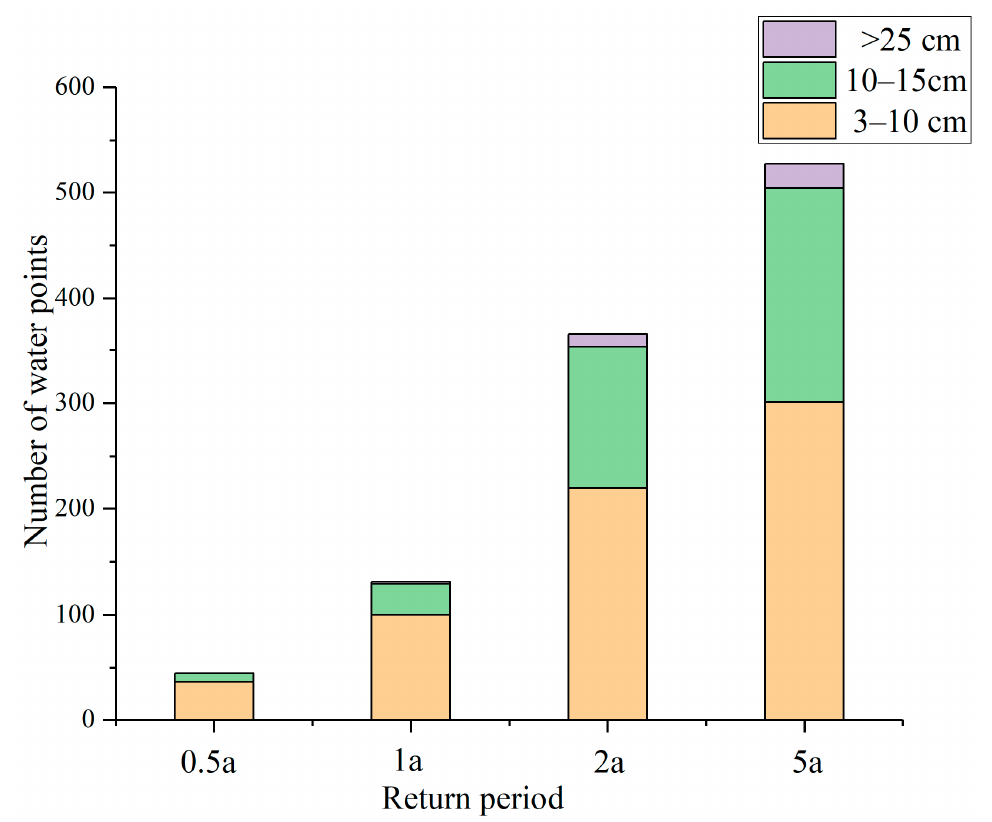
Figure 7. Inundation infographic under different return periods.